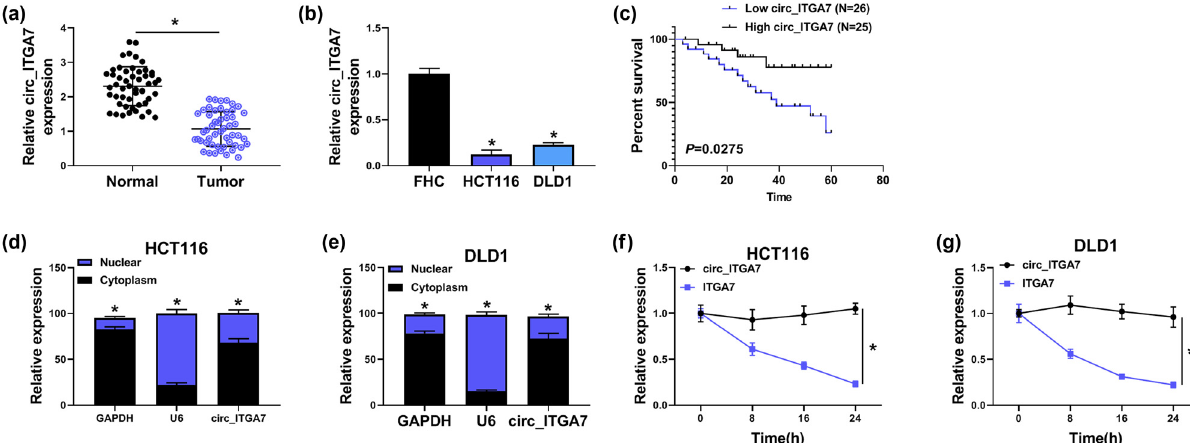
Figure 1: circ_ITGA7 is highly expressed in CRC tissues and cells. ( a and b ) Expression level of circ_ITGA7 in CRC tissues and matched normal tissues, as well as in CRC cell lines and normal FHC cells were analyzed using qRT - PCR. ( c ) Kaplan – Meier overall survival curve for CRC patients classi fi ed according to relative circ_ITGA7 expression level. ( d and e ) Cellular distribution of circ_ITGA7 was analyzed by cellular RNA fractionation assays in HCT116 and DLD1 cells. ( f and g ) Relative RNA levels of circ_ITGA7 and ITGA7 were measured by qRT - PCR in HCT116 and DLD1 cells after treatment with Actinomycin D at the indicated time points. * P <